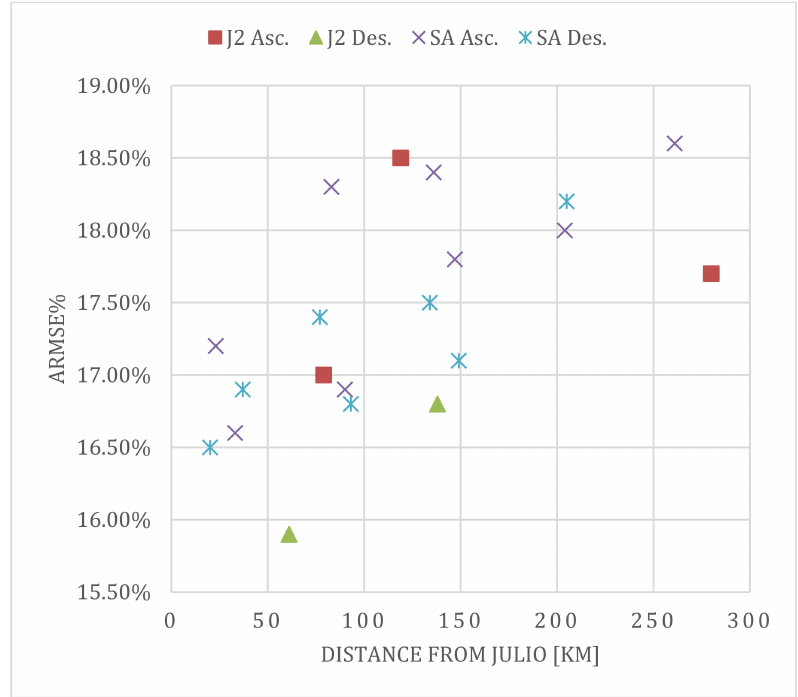
Figure 3. Analysis of the sensitivity of the RFA error (in terms of ARMSE%) to the distance from JULIO. Jason 2 and Saral / Altika ARMSE% obtained in the training as function of the distance from JULIO are shown, di ff erentiating the ascending and descending